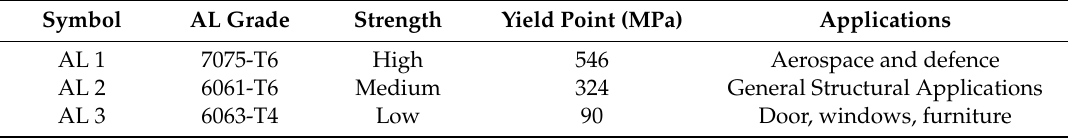
Table 2. The three aluminium grades used for the auxetic core and their applications.